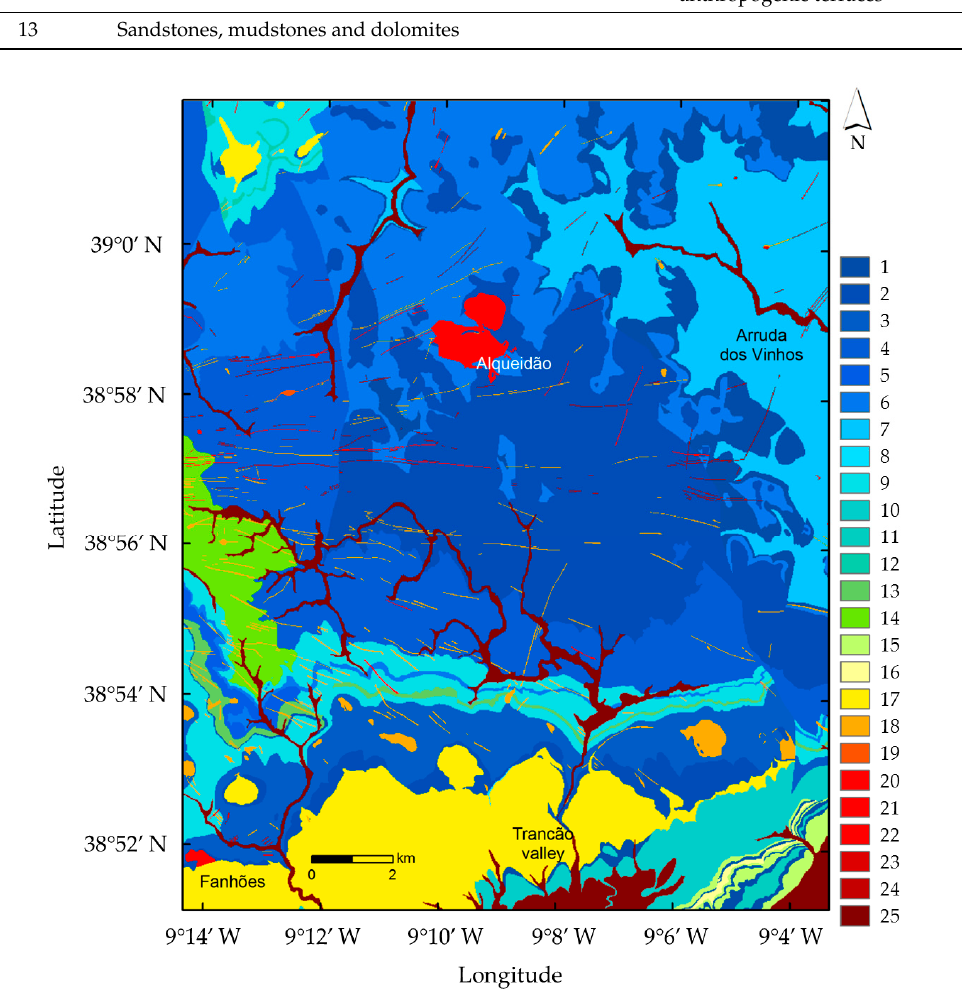
Figure 3. Lithological units map of the study area.